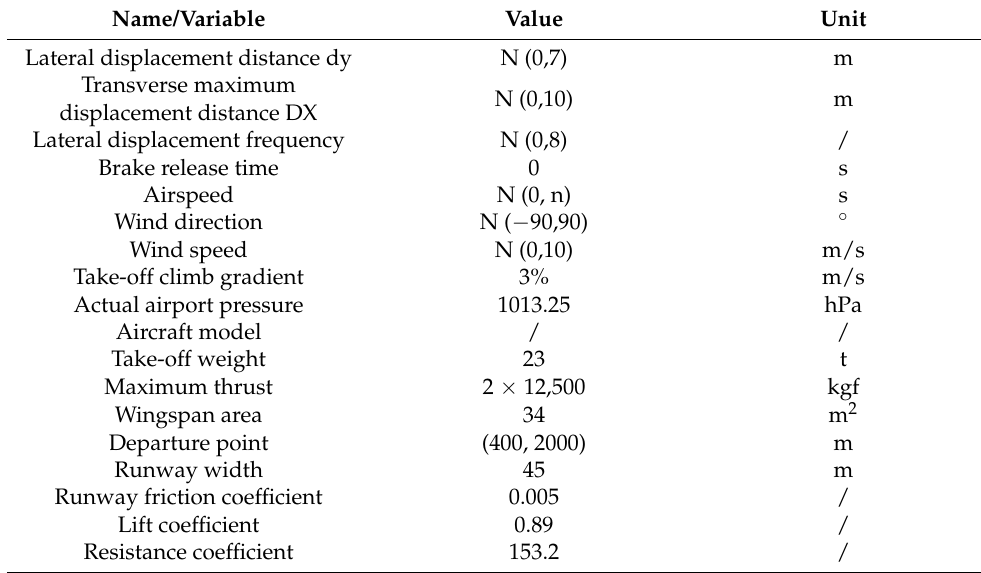
Table 10. Take-off model parameter settings.